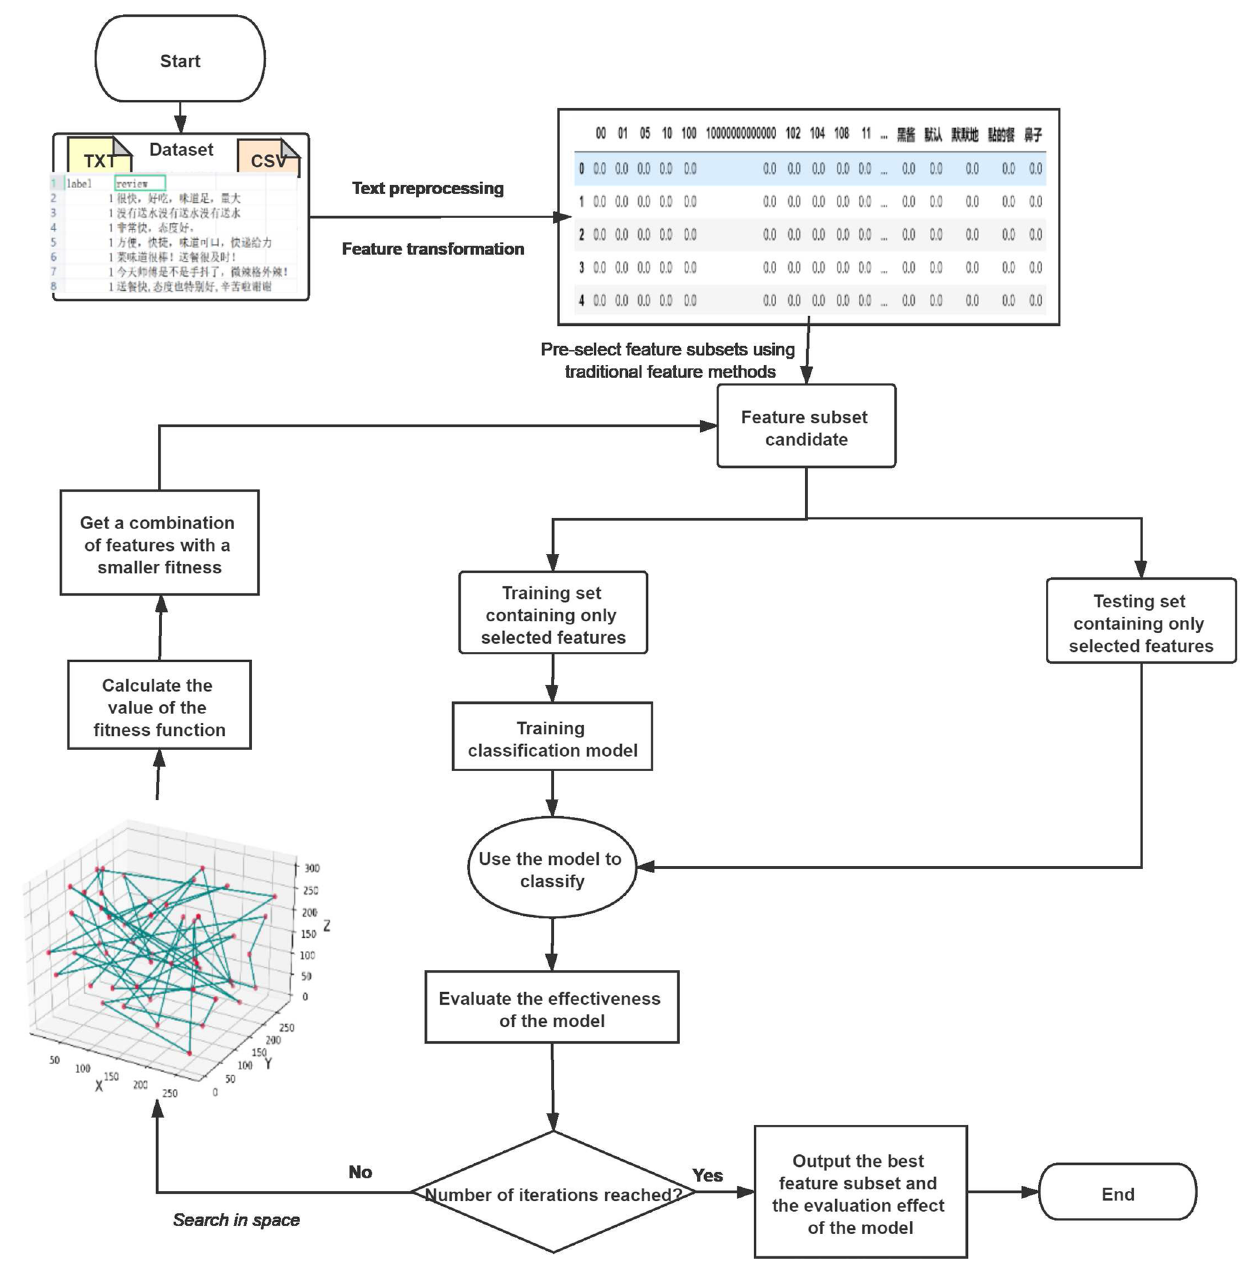
Fig. 10 Steps of Chinese text classification based on CAFSA